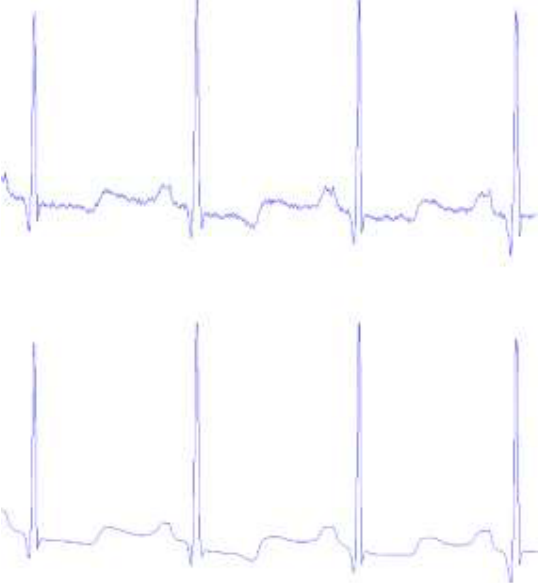
Figure3. Part of ECG signal from MIT-BIH database before and after